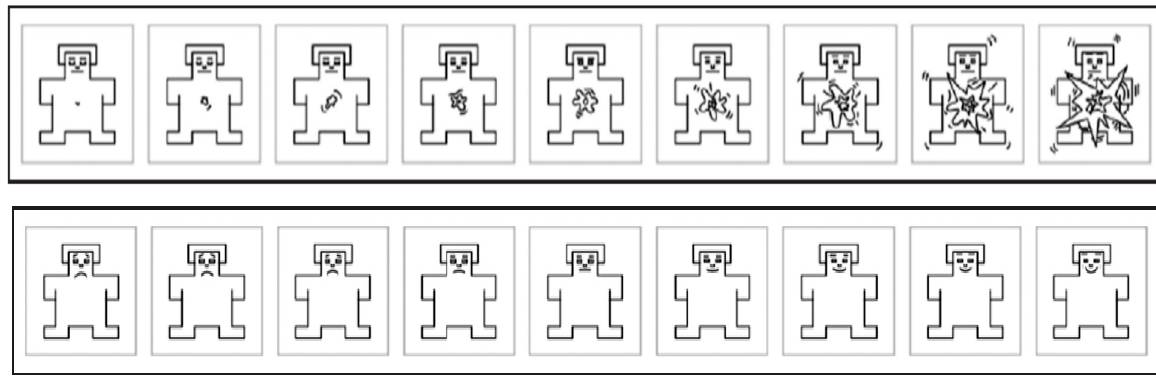
Figure 2. Manikins used for self-assessment.